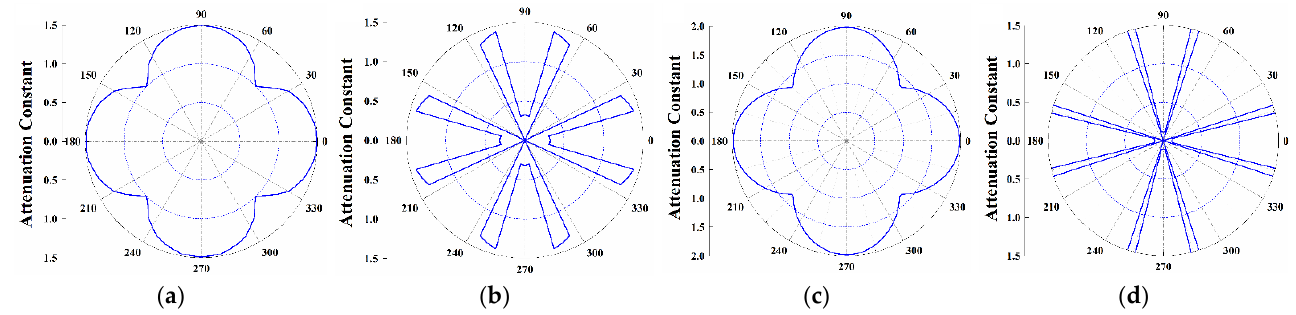
Figure 8. Directional attenuation constants of the phononic plate with fluid loading at: ( a ) 360 Hz and ( b ) 490 Hz; the phononic plate without fluid loading at: ( c ) 560 Hz and ( d ) 970 Hz.